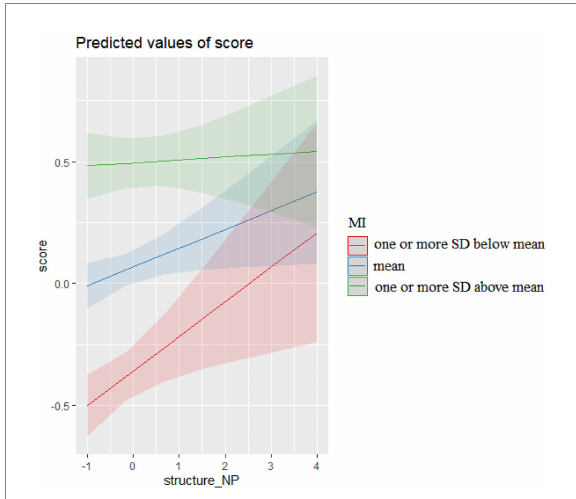
FIGURE 3 The interaction effects of NP sequences and MI on essay scores.